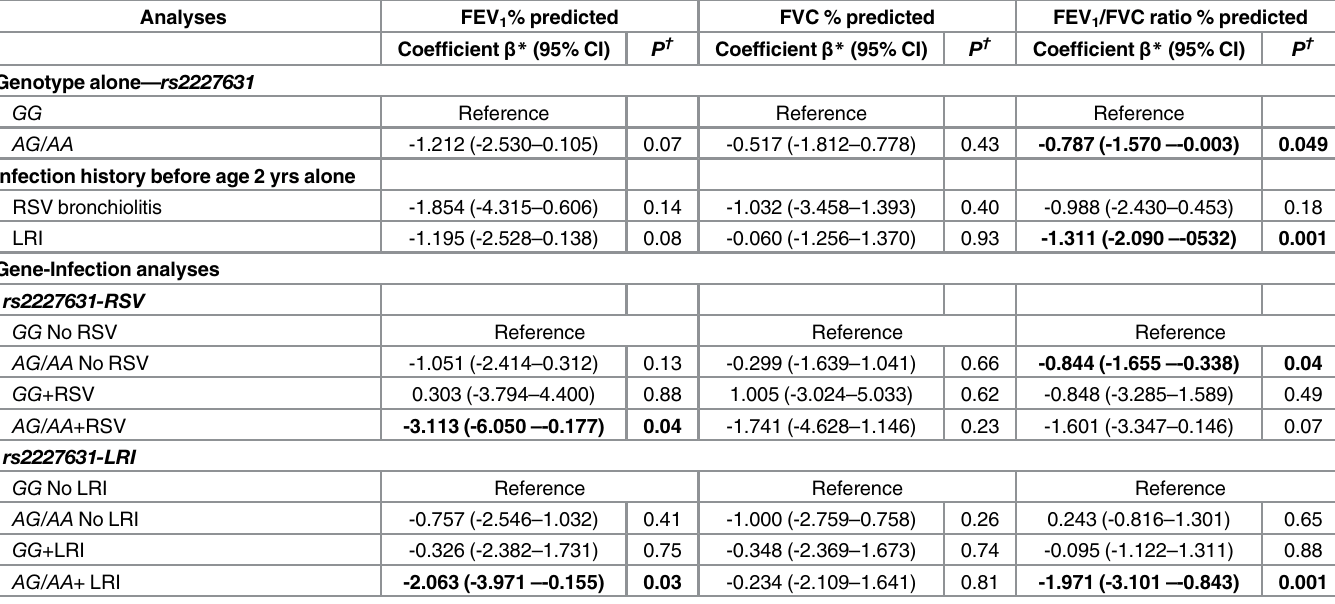
Table 4. Adjusted effect of rs2227631 , infection and rs2227631 gene-infection interaction on lung function in asthmatic subjects. Analyses